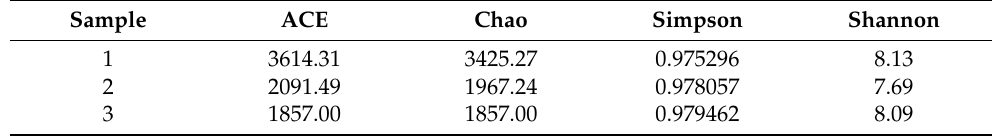
Table 4. Alpha diversity of the different samples.